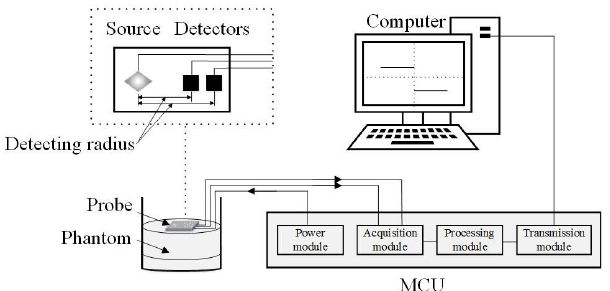
Fig. 1. The schematic diagram of the photoelectric monitoring